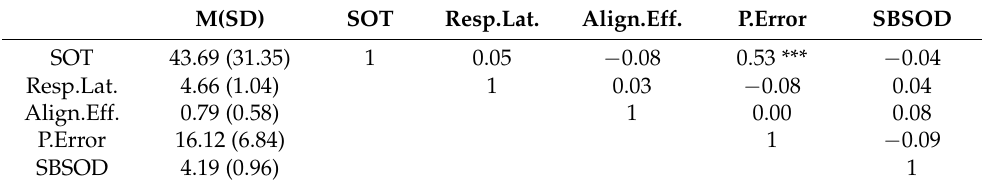
Table 1. Correlations and Descriptive Statistics for variables of Experiment 1 and 2. M(SD) SOT Resp.Lat. Align.Eff. P.Error SBSOD SOT 43.69 (31.35) 1 0.05 − 0.08 0.53 *** − 0.04 Resp.Lat. 4.66 (1.04) 1 0.03 − 0.08 0.04 Align.Eff. 0.79 (0.58) 1 0.00 0.08 P.Error 16.12 (6.84)